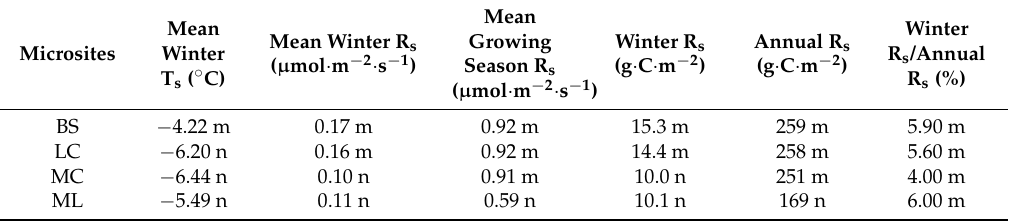
Figure 1. Seasonal variations in soil respiration (R s ), soil temperature (T s ) and soil water content (SWC) for four microsites including bare surface (BS), lichen crust (LC), moss crust (MC), and mixed crust of both moss and lichen (ML) in winter (from late November 2013 to February 2014). Data points in the left panels are daily means, and those in the right panels are hourly means. Table 1. Winter soil respiration (R s ) and its contribution to annual total of R s for four microsites including bare surface (BS), lichen crust (LC), moss crust (MC), and mixed crust of both moss and lichen (ML) a